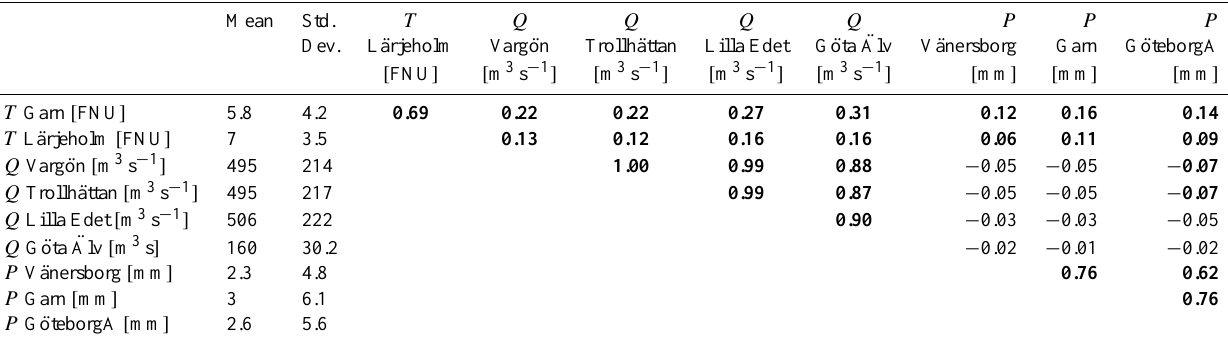
Table 5. The table shows mean, standard deviation, and correlation for the variables turbidity ( T ), flow ( Q ) and precipitation ( P ) along the river (2004–2007). Correlation in bold is significant at p <